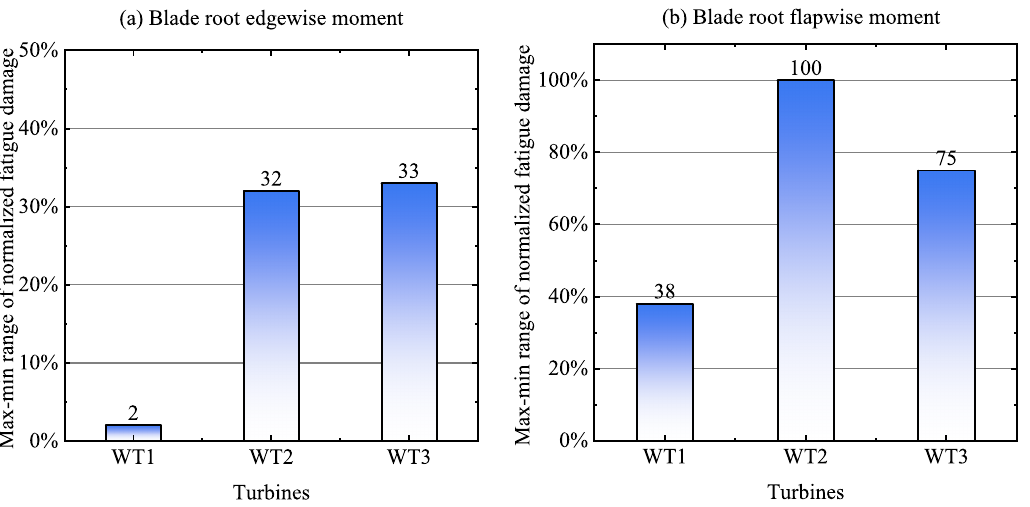
Figure 13. Max–min range of normalized fatigue damage of